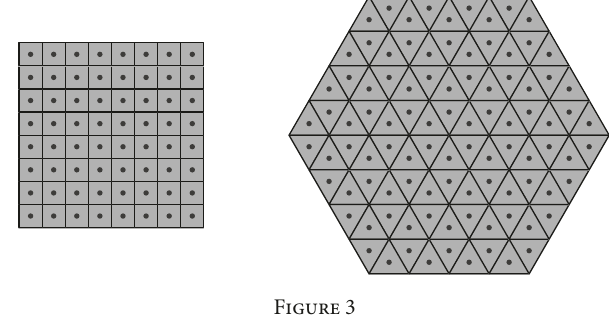
𝑗 } , where the scaling function 𝜑 = 𝐸𝜒 Δ (2) {𝑉 2 Δ 2 , with 2 2 being the triangle with vertices in (0, 0) , (√3/2, 0) , and (√3/4, 3/4) and 𝐸 = 4/ 4 √27 ; the lattice is Γ 2 = Z 2 , where 𝑐 = (1/4) ( 0 3√3 ) ; the finite group 𝐵 𝑐 1 1 2 is 6 3 the rotation group of a regular hexagon with vertices in the unit circle; the scaling is given by 𝐴 2 = {𝑎 𝑗 } , −√3 ) where 𝑎 = ( 1 √3 1